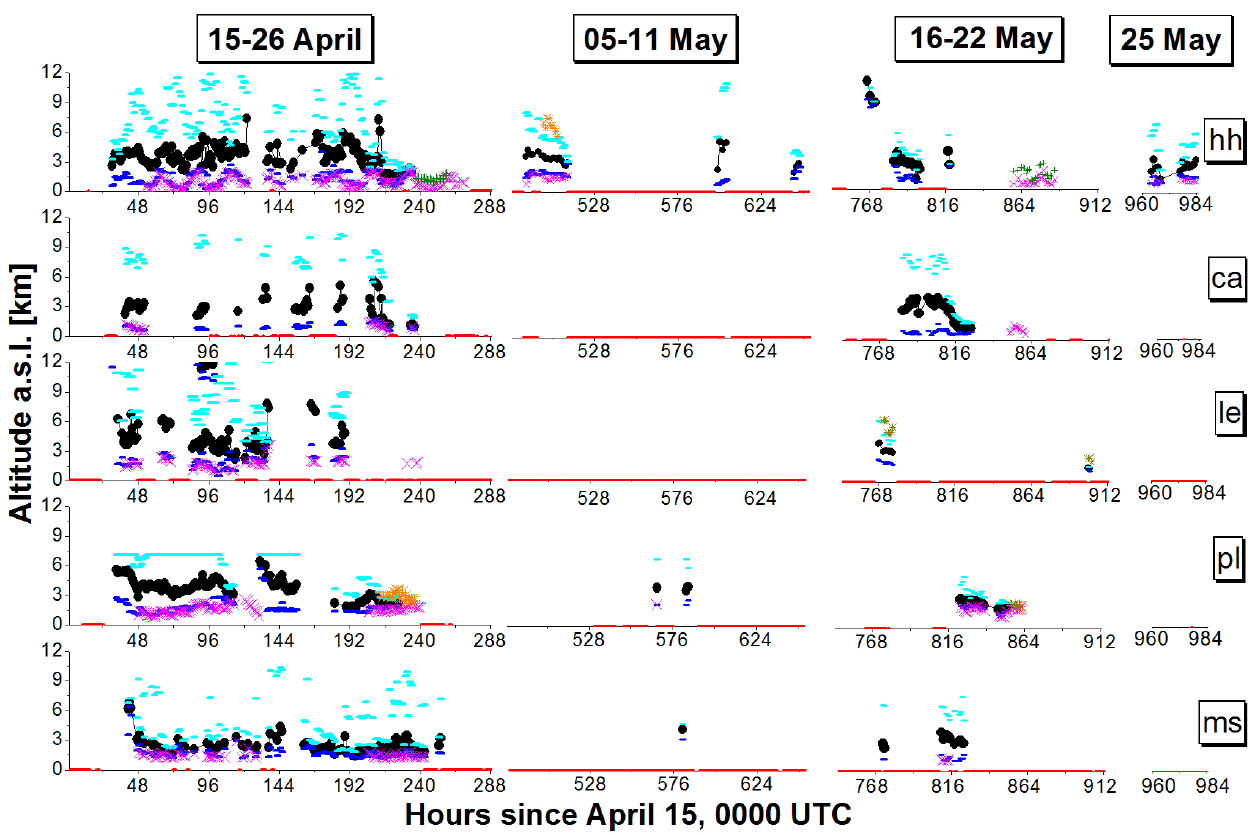
Fig. 5. Central Europe cluster: Hamburg (hh), Cabauw (ca), Leipzig (le), Palaiseau (pl) and Maisach (ms). The following quantities are reported hourly: center of mass of the identified volcanic layer (black dots), base and top of the identified volcanic layer (blue and cyan lines, respectively). Mixing with dust and continental aerosol is highlighted by orange and dark yellow symbols, respectively. Mixing with local aerosol above the PBL is reported in green. The intrusion in the PBL and, therefore, the mixing with local aerosol is indicated by a magenta cross located at the top of the PBL as obtained from lidar observations. Red line on the abscissa axes indicates no